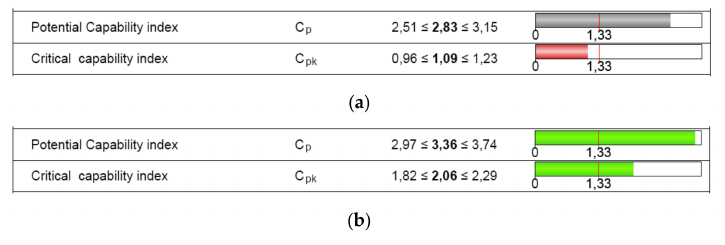
Figure 14. Process capability analysis report: ( a ) height dimension (H); ( b ) diameter dimension (D).